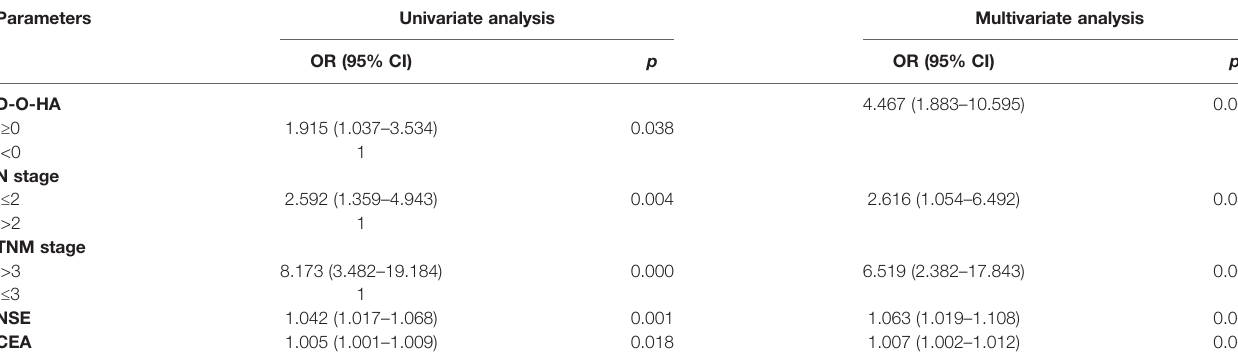
TABLE 2 | Univariate and multivariate Cox regression analyses of variables considered for PFS of SCLC patients.